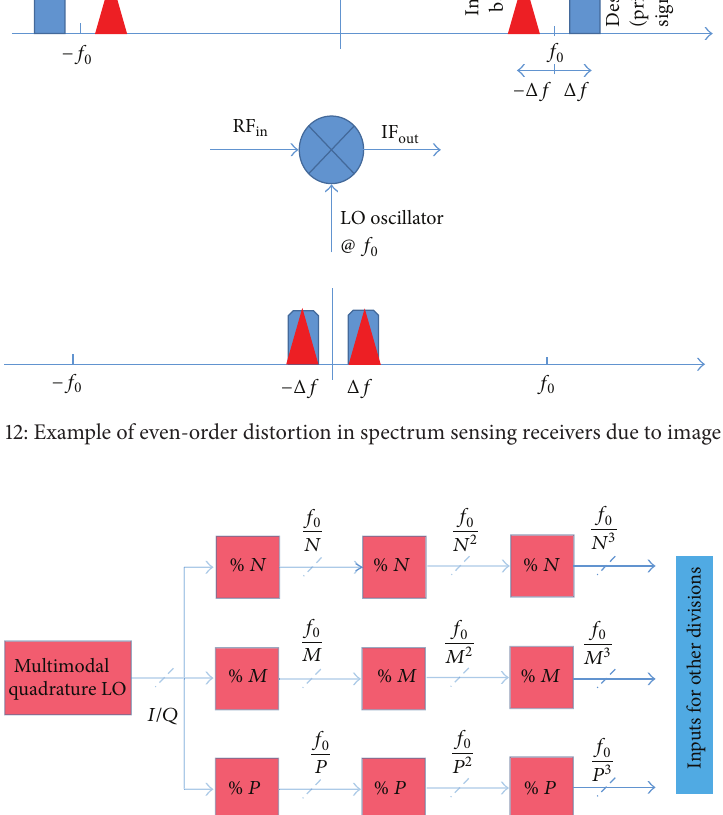
Multimodal quadrature LO